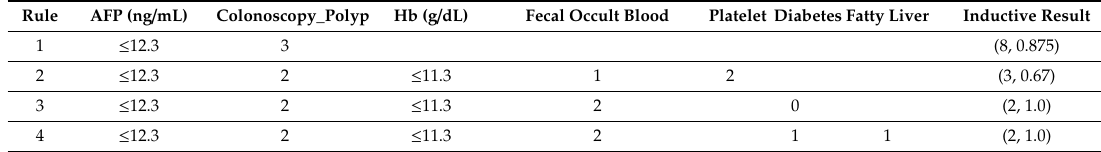
Figure 3. Decision tree model 1 (no pyogenic liver abscess variable). Table 9. Model 1 (no bacterial liver abscess variable) classification results—colorectal cancer.